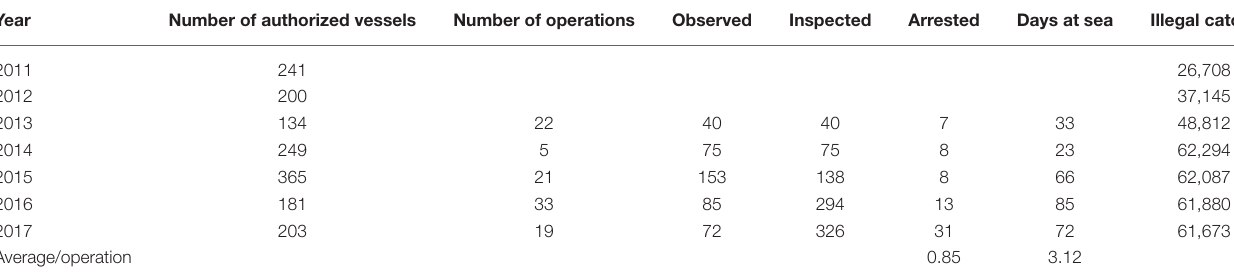
TABLE 2 | Total licensed industrial fleet, and total monitored and arrested vessels,